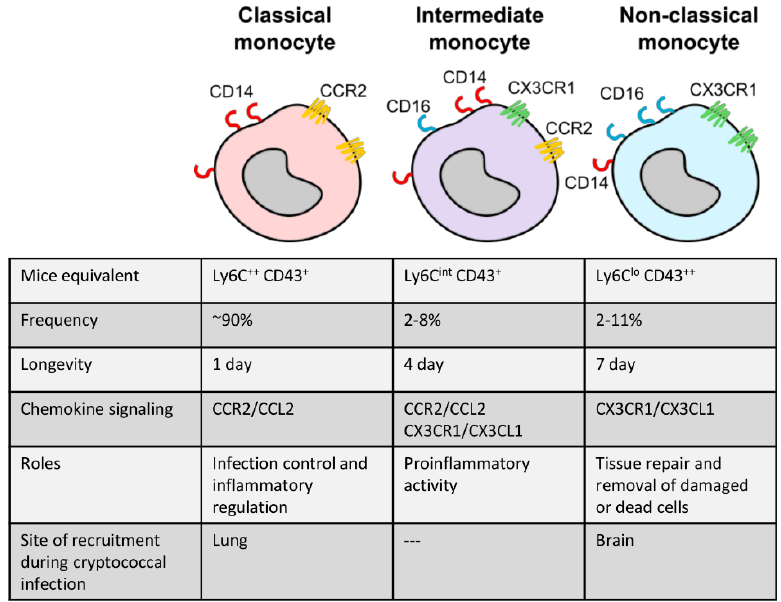
Figure 1. The three subtypes of monocytes that are best characterized to date: classical monocytes (CD14 ++ CD16 − ), intermediate monocytes (CD14 ++ CD16 + ), and non-classical monocytes (CD14 + CD16 ++ ). Murine markers and selected features for each subset are shown.